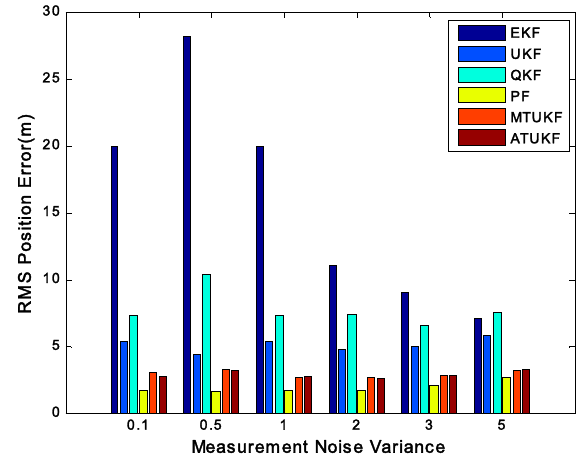
Figure 3. RMS position error for different noise variances. Table 1. Comparison of the computation times of different filtering algorithms(s). UNGM: univariate nonstationary growth model.